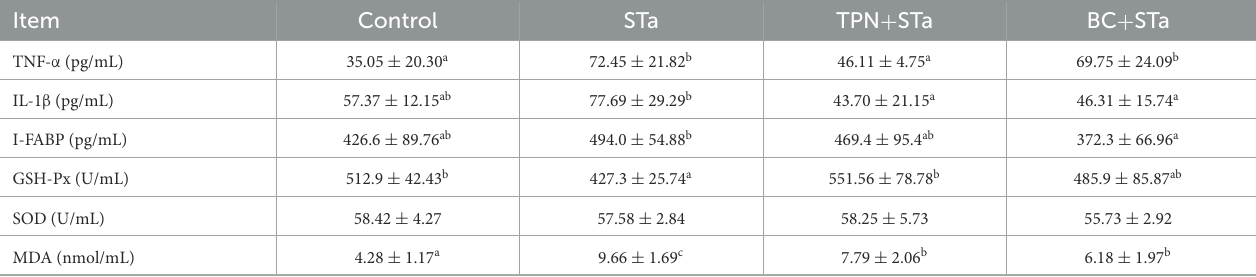
TABLE 4 Inflammatory, intestinal injury, and redox index in